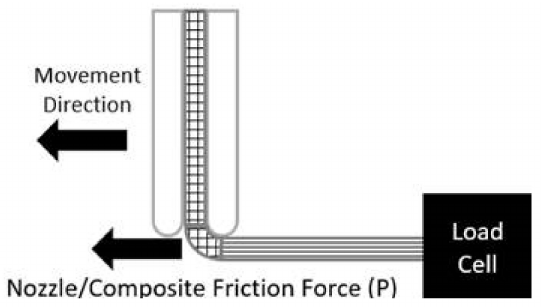
Figure 8. Nozzle/composite tow friction force testing setup.